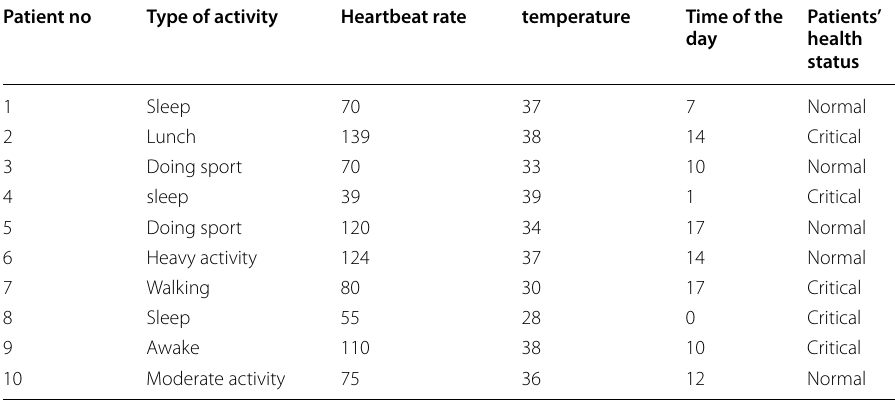
Table 3 An example of the dataset suggested in the proposed method Patient